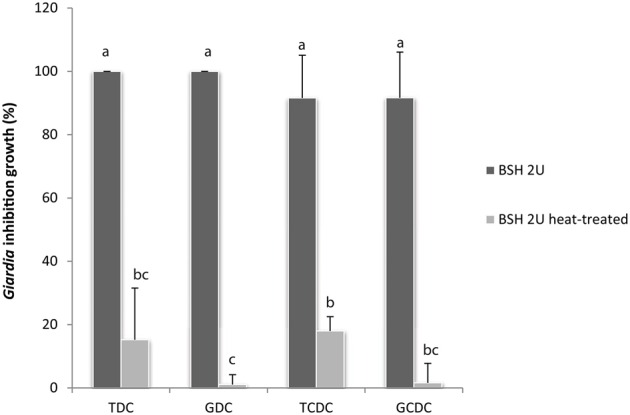
G. duodenalis growth is inhibited by enzymatically active C. perfringens BSH in the presence of conjugated bile salts (0.2 g/L). Commercial C. perfringens BSH, enzymatically active or heat-inactivated (100°C, 5 min) was added to G. duodenalis culture medium in the presence of either GDC, glycodeoxycholate; GCDC, glycochenodeoxycholate; TDC, taurodeoxycholate or TCDC; taurochenodeoxycholate. Values are the mean ± SD of at least three independent experiments. Letters indicate significant differences between treatments (Kruskall-Wallis, p < 0.05).